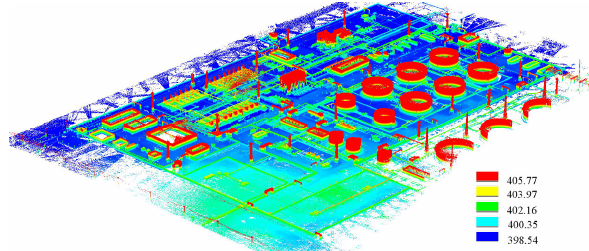
Figure 2 . Point cloud displayed by elevation for the territory of central gathering oil station.